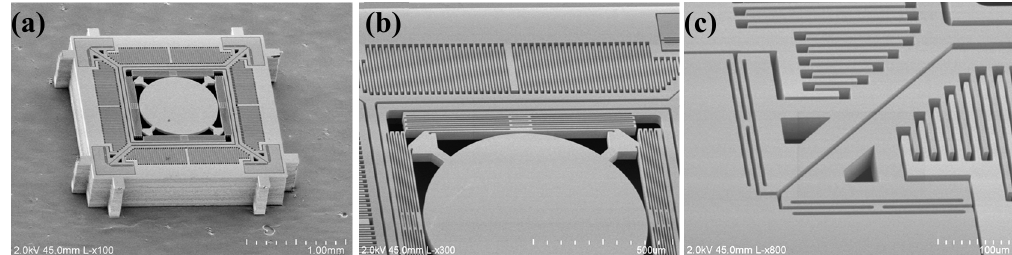
Figure 6. Scanning electron microscope (SEM) images of the fabricated scanner. ( a ) the complete device structure; ( b ) the multi-turn folded-beam spring; and ( c ) the H-shaped torsional spring.